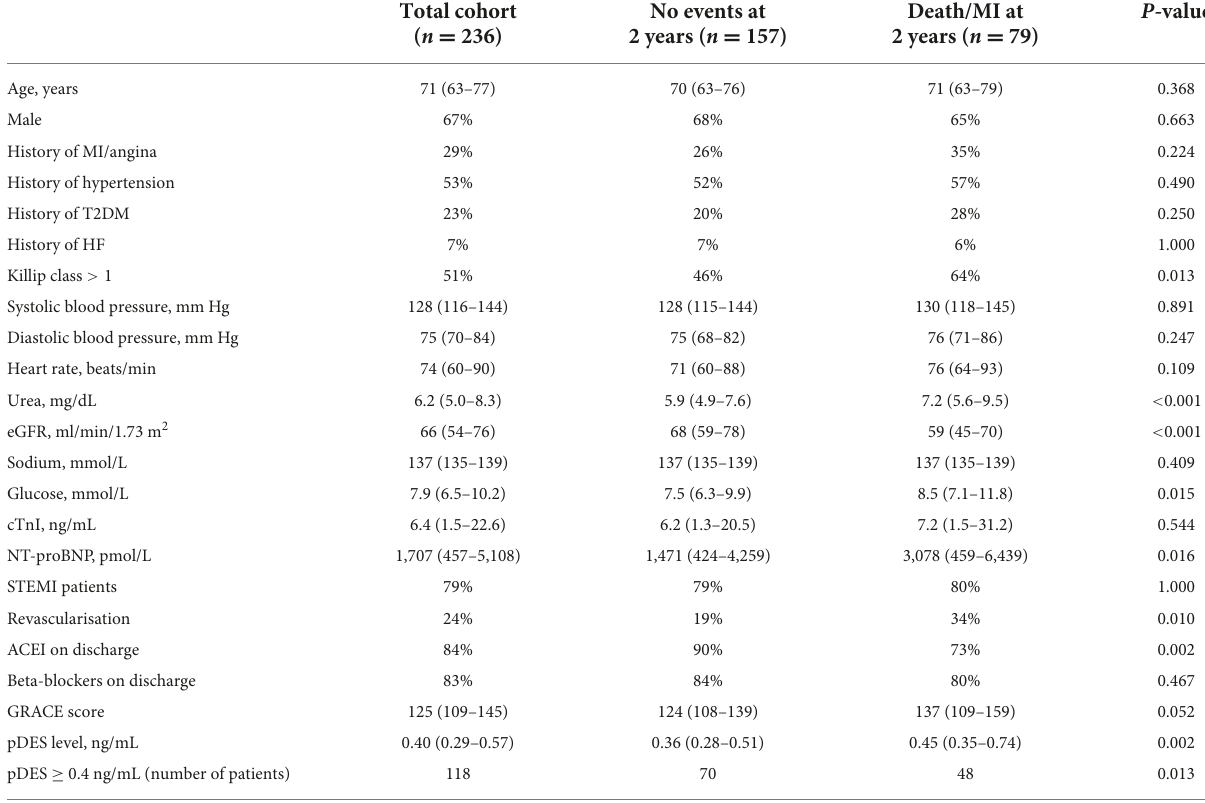
TABLE 1 Study demographics for the total acute myocardial infarction (AMI) cohort and split according to outcomes of all-cause mortality or reinfarction at 2 years [death/myocardial infarction